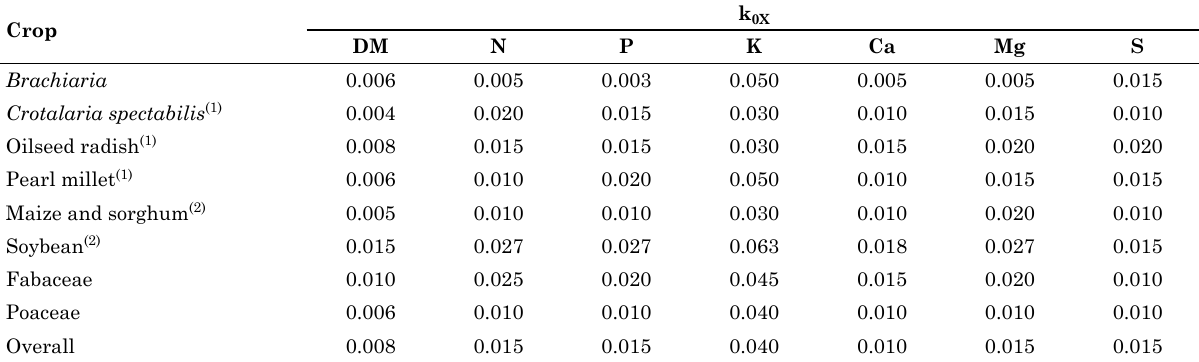
table 3. decomposition constant (k 0X ) of dry matter (dm) and of macronutrients of the main crops that preceded this